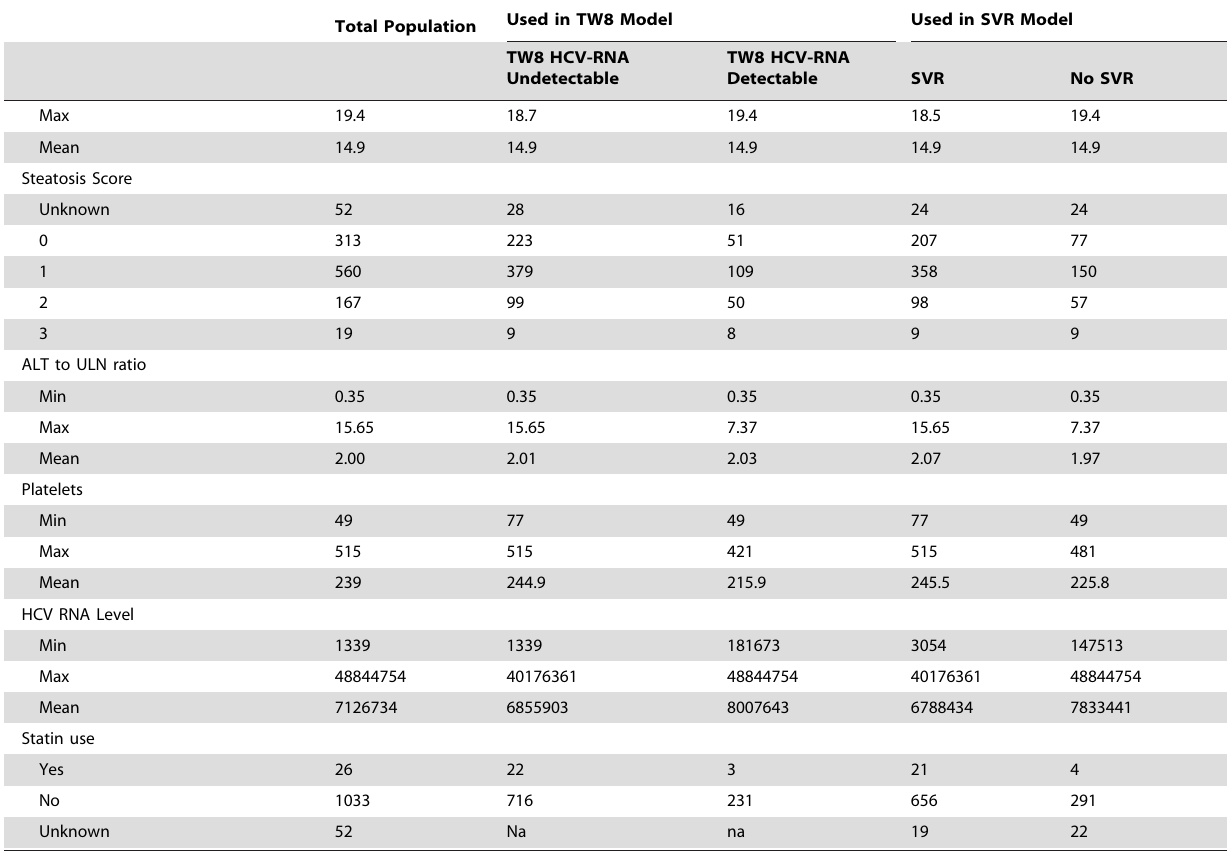
Total Population Used in TW8